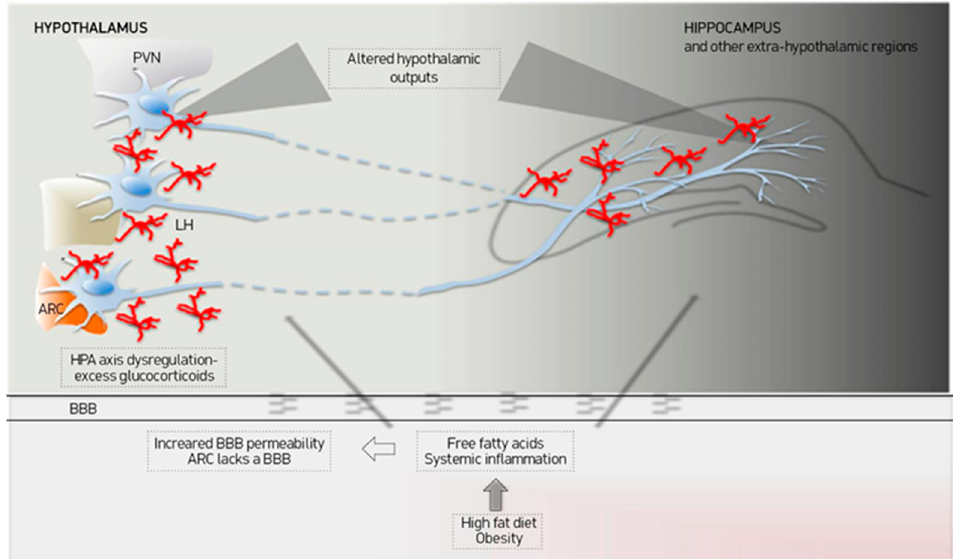
Figure 2. A.A. Miller, S.J. Spencer / Brain, Behavior, and Immunity 42 (2014) 10–21 [58]. Proposed mechanisms of cognitive impairment in obesity. Obesity is characterized by increased proinflammatory cytokines and free fatty acids that can access central nervous system through increased BBB permeability or through ARC that lacks an effective BBB. Hypothalamic inflammation can probably affect the hypothalamic outputs to the other brain regions and the Hypothalamic-Pituitary-Adrenal (HPA) axis activity. ARC: Arcuate nucleus, BBB: Blood-brain barrier, LH: Lateral hypothalamus, PVN: Paraventricular nucleus . Over the last decades, it has been revealed that the brain monoaminergic systems, which include serotonin (5 hydroxy tryptamin 5HT), dopamine, and noradrenaline, play